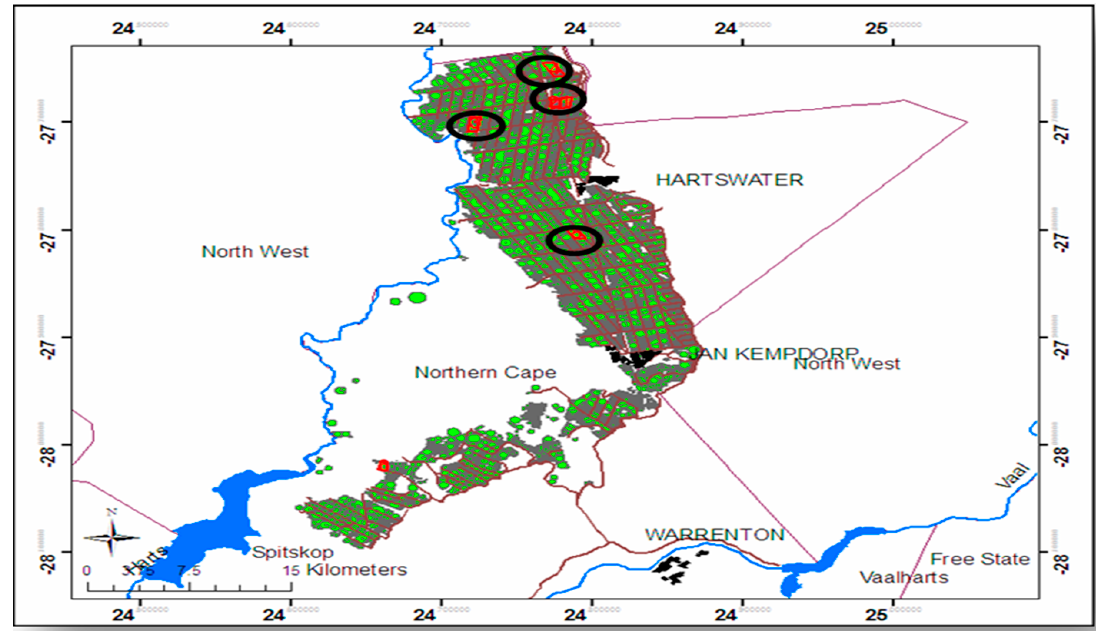
Figure 2 . Map of the study area . Source: Van Rensburg et al. [29]. Figure 2. Map of the study area. Source: Van Rensburg et al.